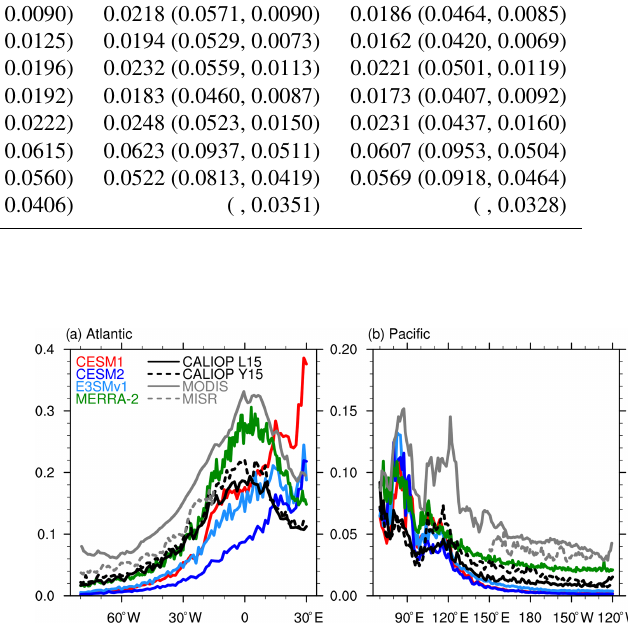
Figure 6. Meridional mean of DOD from model experiments, CALIOP, MODIS, and MISR across the (a) Atlantic (0–35 ◦ N) and (b) Pacific (30–60 ◦